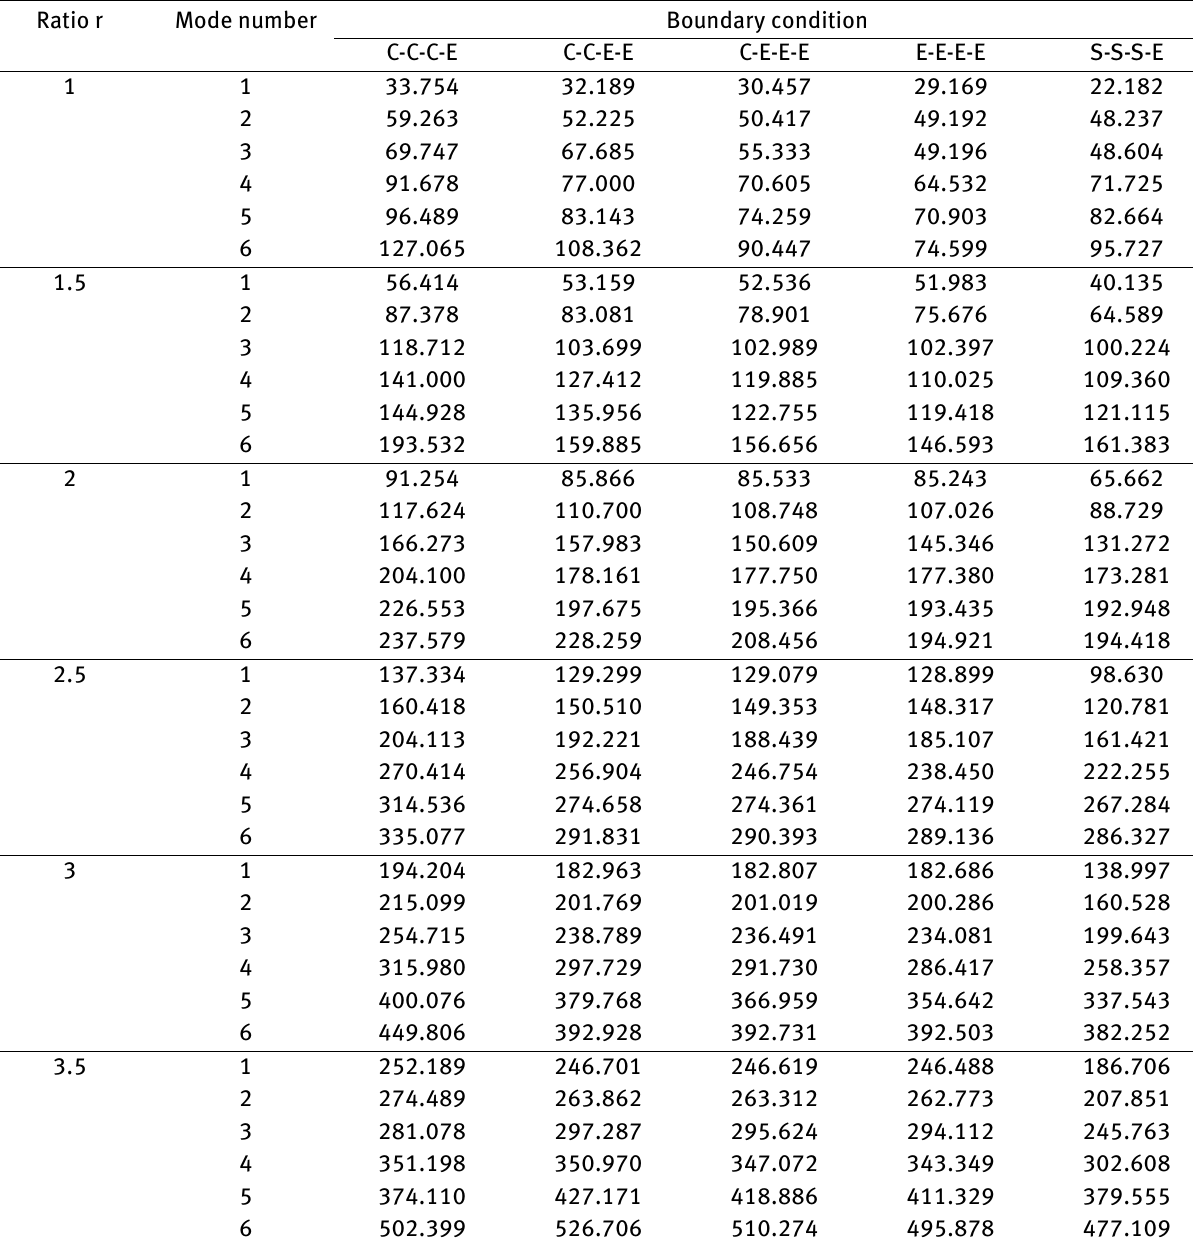
Table 8: The first six parameters Ω for the rectangular thin plates with elastic boundary conditions and different aspect ratios. Ratio